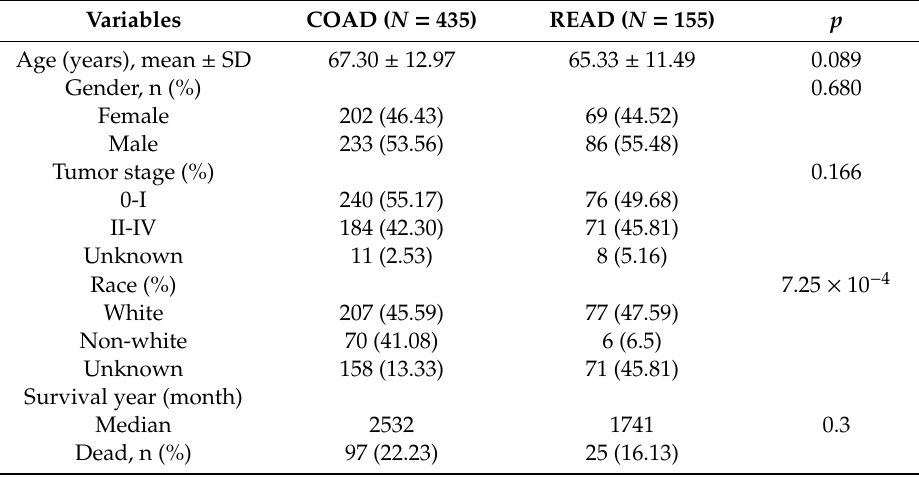
Table 1. Demographic distribution of discovery and validation study